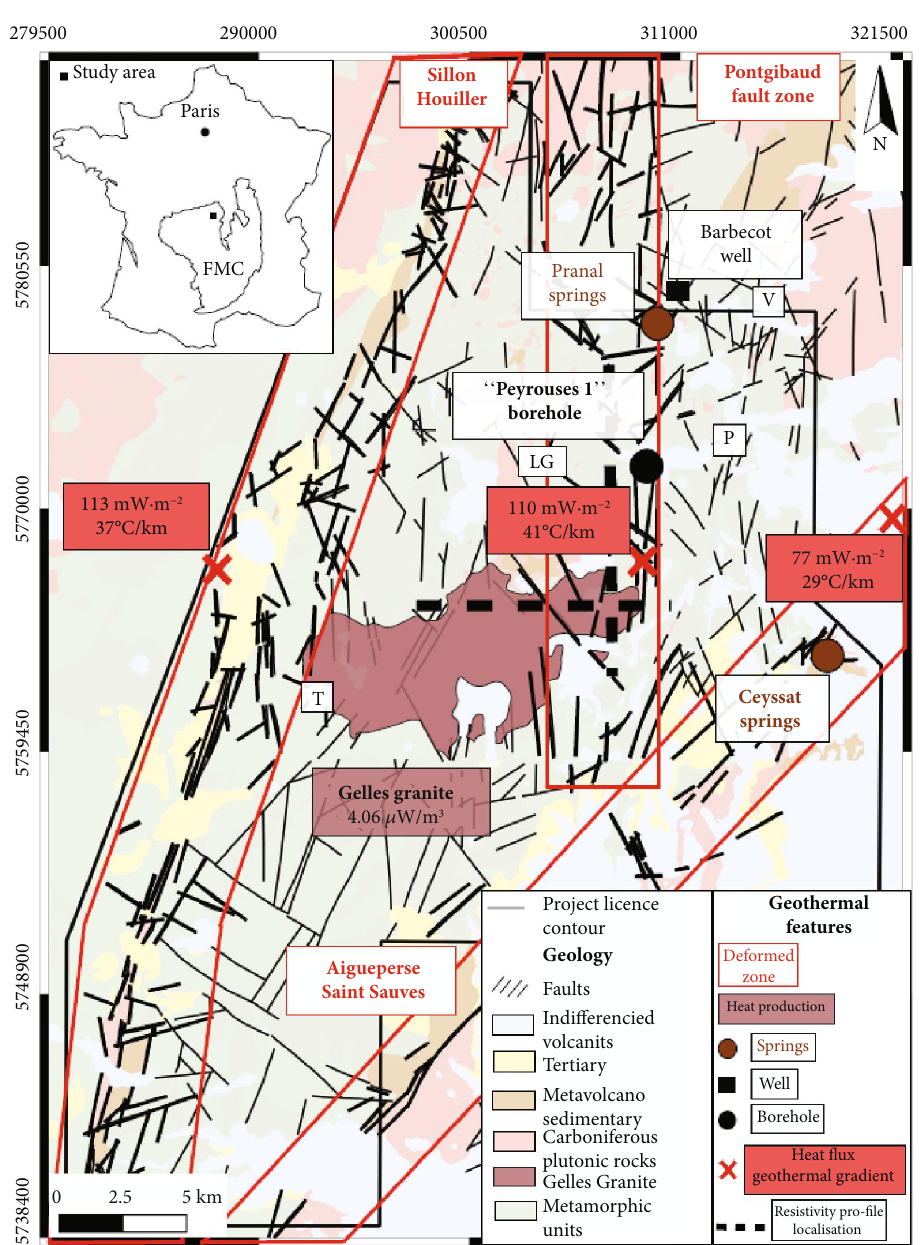
Figure 1: Geological and geothermal features in the “ La Sioule ” licence area (black contour). FMC: French Massif Central. Heat fl ow and geothermal gradient (red crosses [56, 57], International Heat Flow Commission). Heat production [58] and resistivity pro fi le (black dashed line [51]). P: Pontgibaud; LG: La Goutelle; V: Villelongue; T: Tortebesse. Coordinate system: WGS84 Pseudo-Mercator EPSG:3857 (after the 1/50,000 th geological map published by